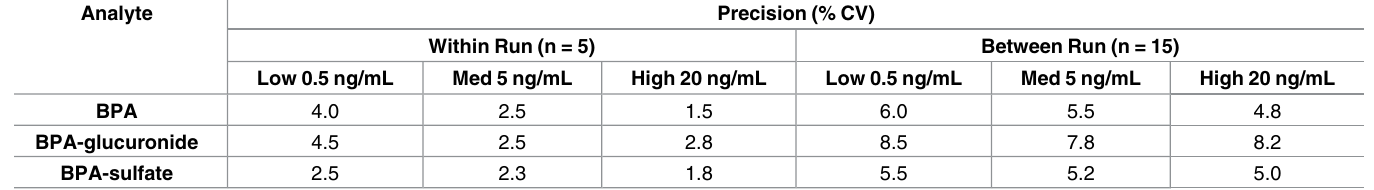
Table 1. Validated method precision established for the direct analysis of BPA and its primary metabolic conjugates in amniotic fluid using LC-MS/MS.